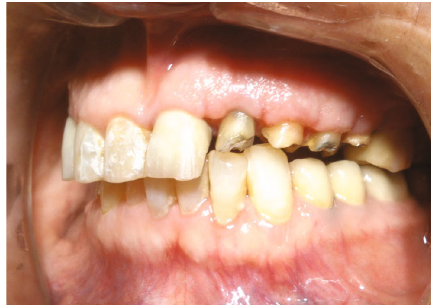
Figure 7: Buccal view of force erupted teeth after crown lengthening.